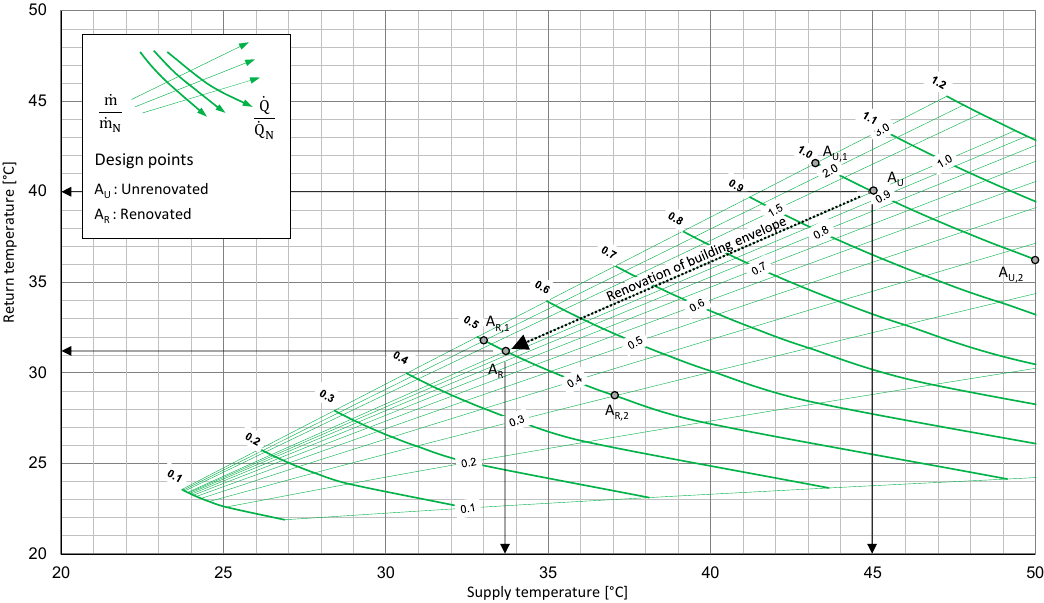
Figure 9. Planning tool for temperature reduction potential for suspended heating panels.